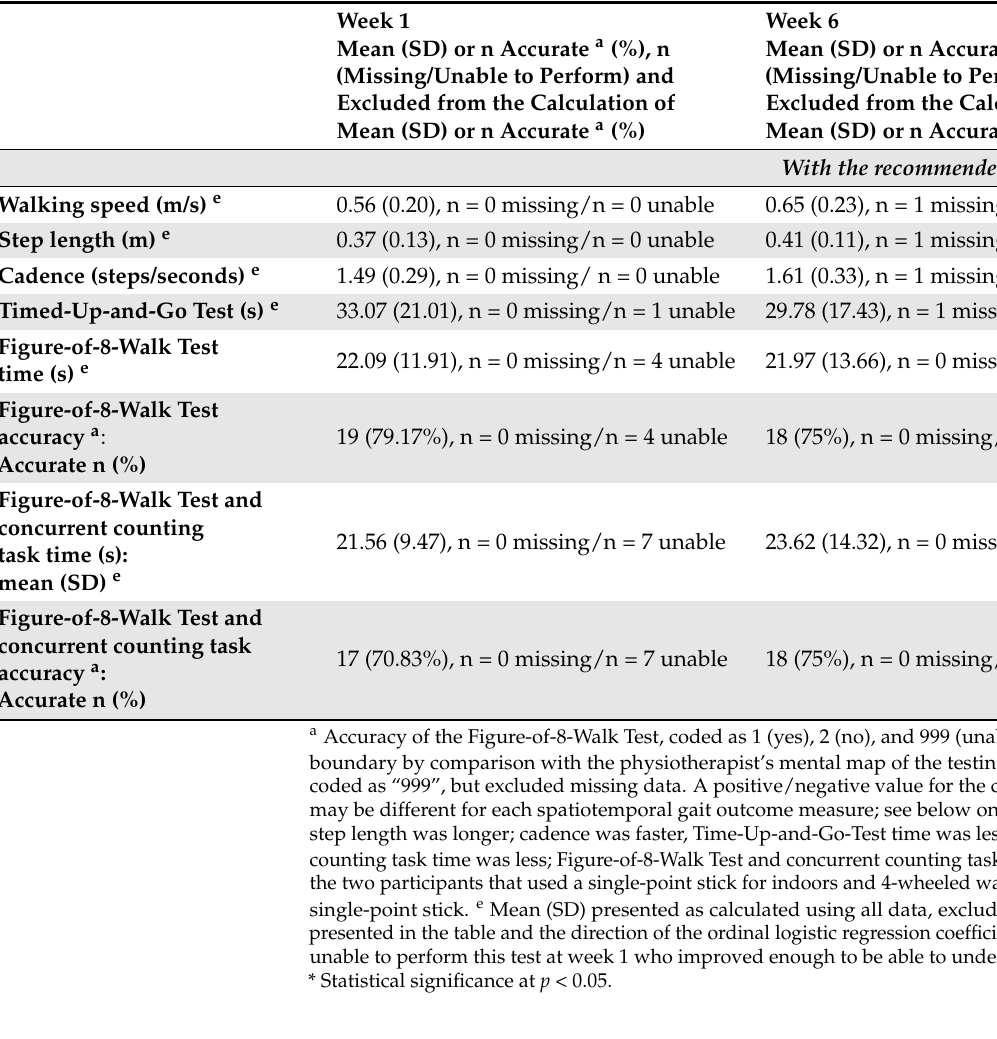
Table 2. Effect of the training program for gait aid use on spatiotemporal gait outcome measures with the recommended gait aid at week 1 (first training session) and week 6 (fourth and last training session).